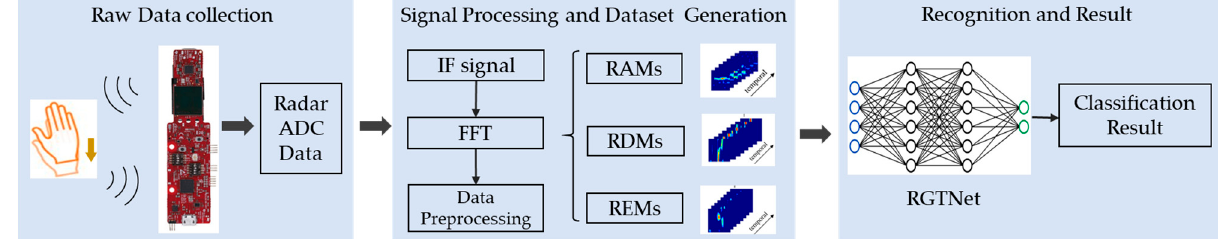
Figure 1. The overview of the proposed gesture recognition system.